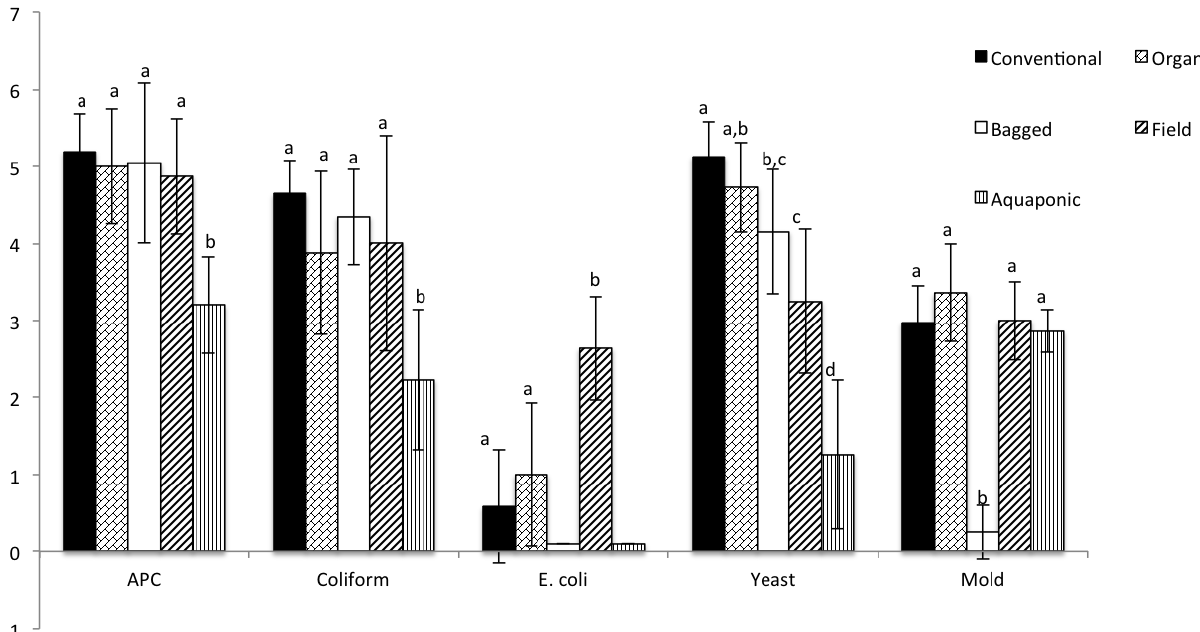
Figure 2. Comparative microbial analysis of conventional, organic, bagged, farmers’ market, and aquaponic lettuce. Bars represent mean aerobic plate counts (APC), coliform, E. coli , yeast, and mold counts (log CFU/g lettuce). Error bars represent standard deviations from the mean. Statistical differences are shown using